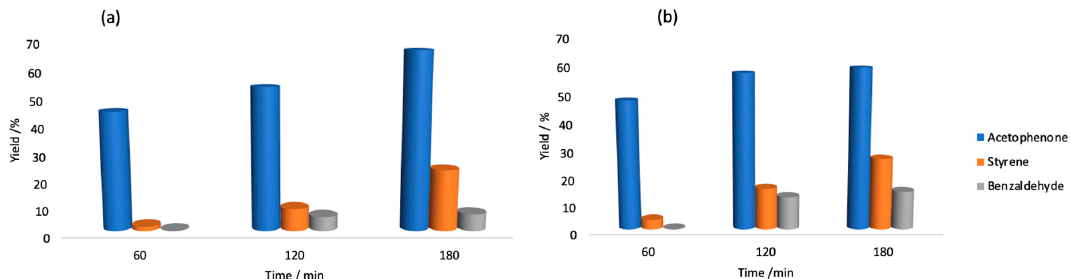
Figure 7. Reaction of 1-phenylethanol to di ff erent products (acetophenone, styrene and benzaldehyde) catalyzed by Fe 3 O 4 / TiO 2 / [FeCl 2 { κ 3 -HC(pz) 3 }] under conventional thermal heating, at di ff erent reaction times and temperatures: ( a ) 80 ◦ C; ( b ) 120 ◦ C.